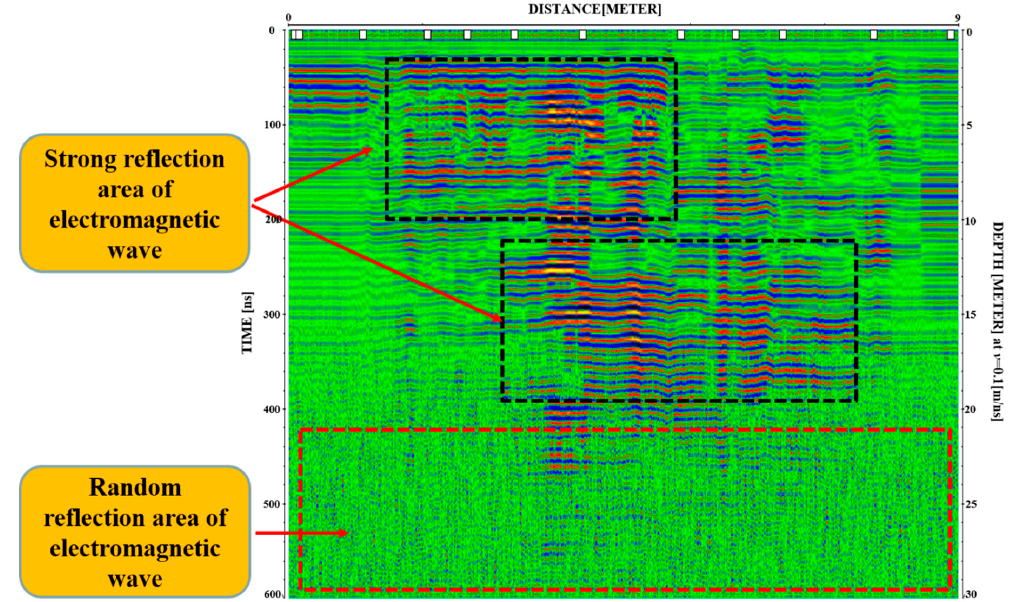
Figure 2. The detection result by geological radar.